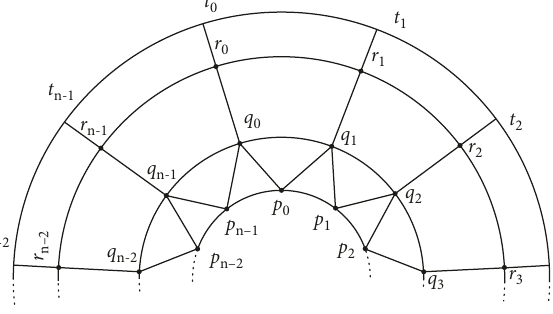
Figure 2: Convex polytope S